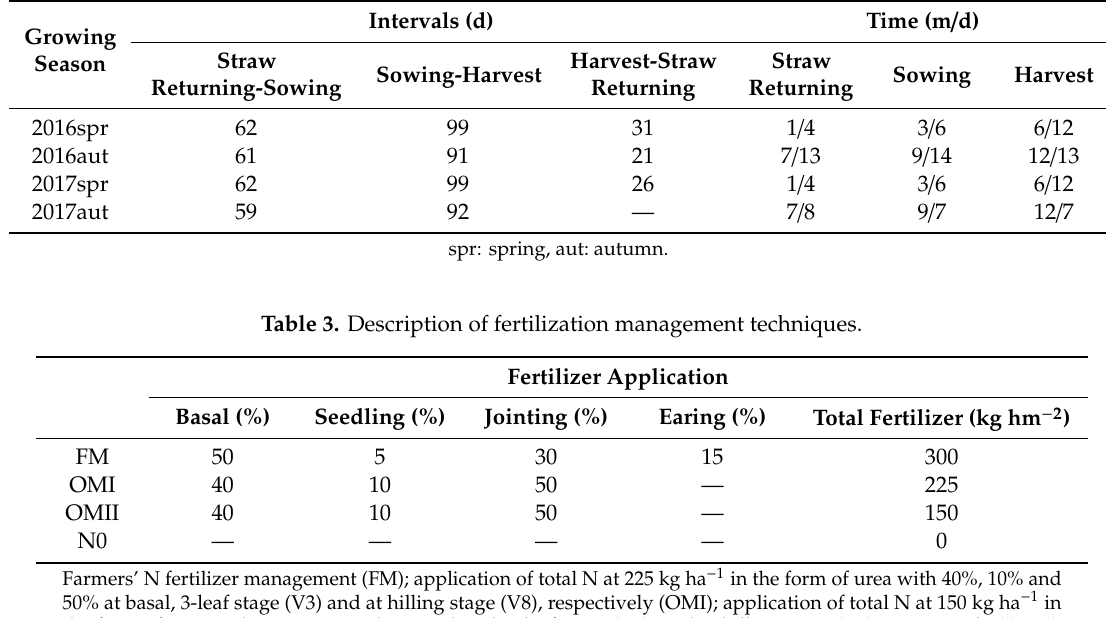
spr: spring, aut: autumn. Table 2. The information regarding the straw return, crop sowing, and harvest during the experimental period.